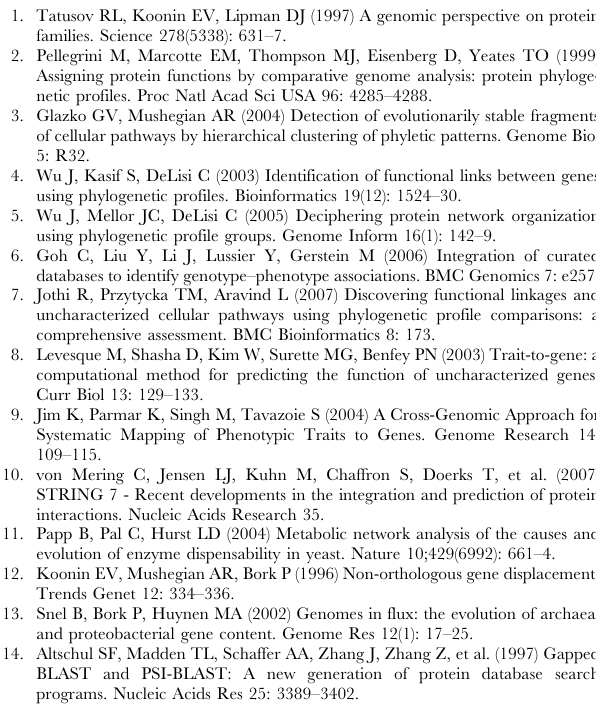
Table S3 The list of complied phenotypic traits obtained from the Genomes OnLine Database (GOLD).